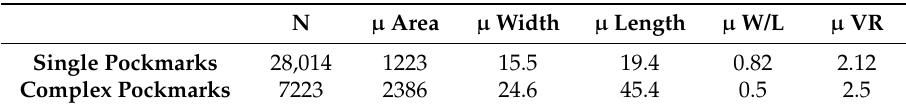
Table 3. Number of depressions mapped (N), mean area (μ Area), mean width (μ Width), mean length (μ Length), mean of the ratio between width and length (μ W/L), and vertical relief (μ VR) from the depressions classified as single and complex pockmarks, respectively.